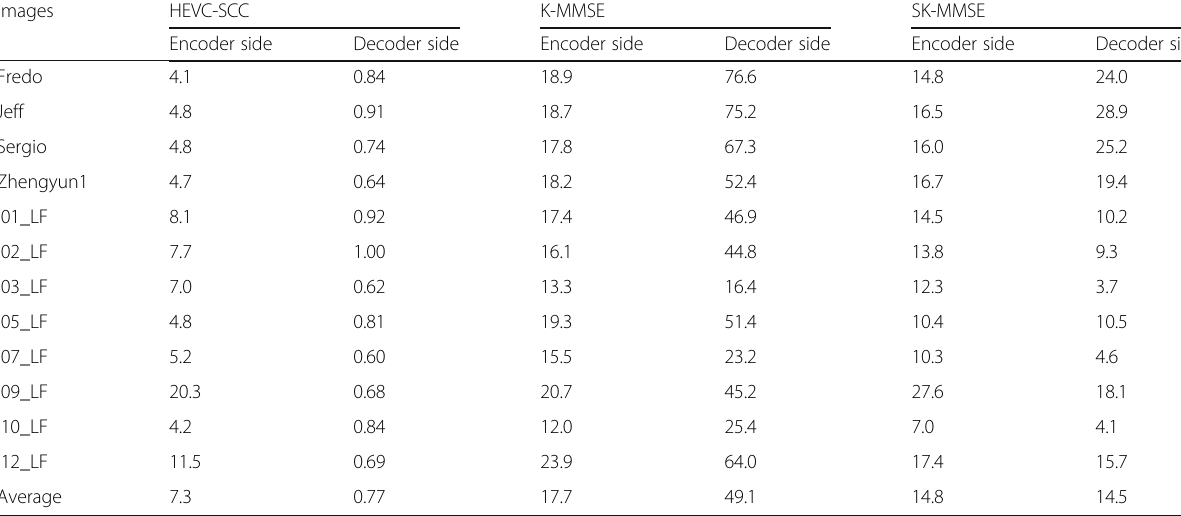
Table 4 Encoding and decoding time ratio to HEVC